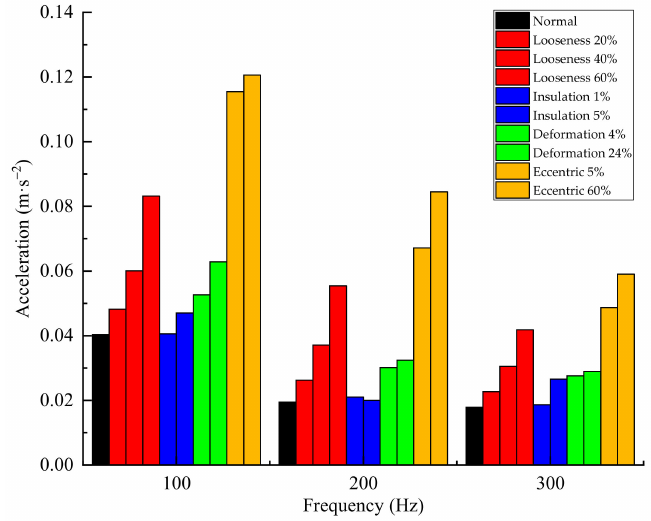
Figure 17. Acceleration frequency domain signal under different faults at the first 300 Hz winding surface point 1.